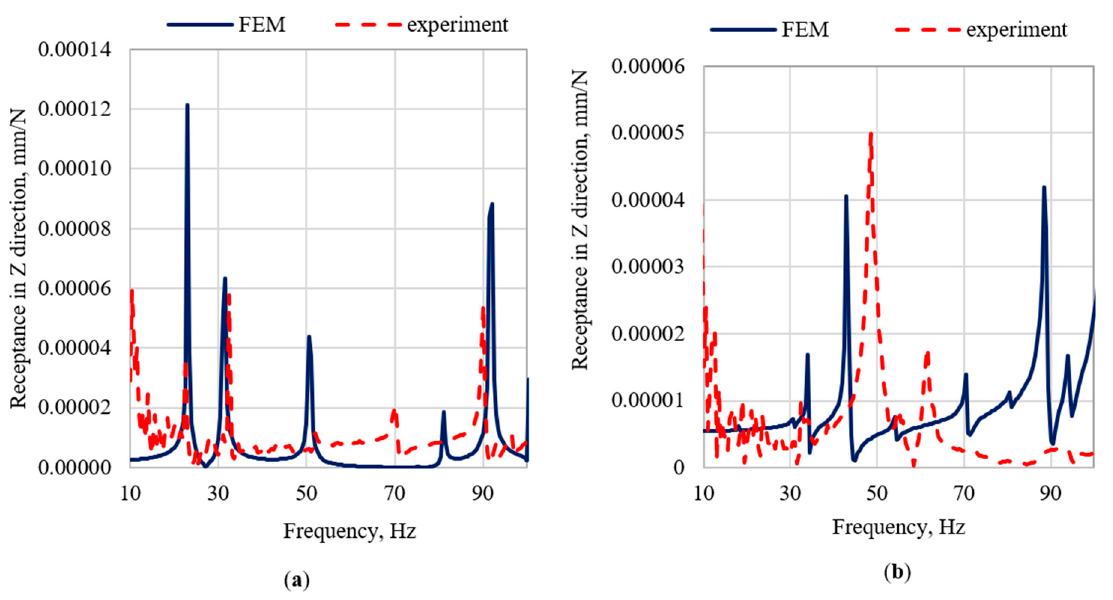
Figure 7. Comparison of selected receptance functions in Z direction ( a ) for the frame and ( b ) for the frame with the robot.